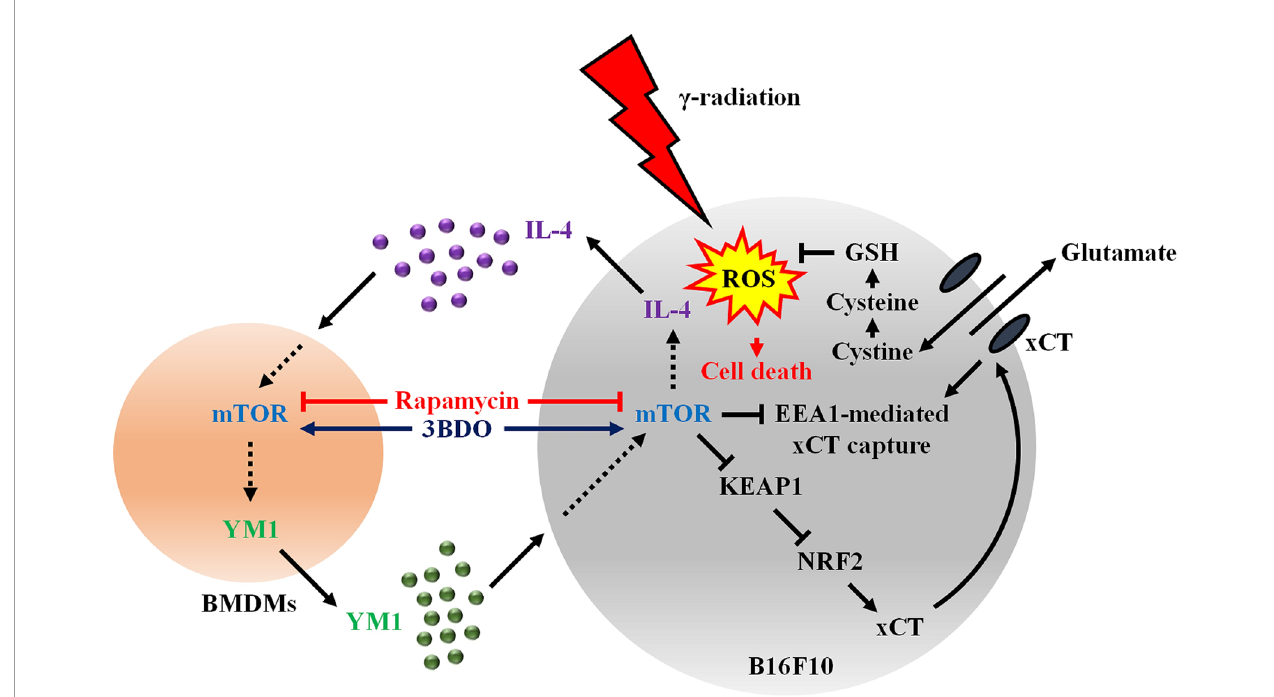
FIGURE 8 | Activated mTOR signaling induces the secretion of IL-4 in melanomas and YM1 in macrophages in the tumor microenvironment. Secreted YM- 1enhances the EEA1-mediated xCT capture via the KEAP1/NRF2 signaling pathway to promote antioxidant mechanisms through GSH in radiotherapy. Therefore, the regulation of mTOR activity using rapamycin could increase tumor sensitivity to g -radiation-induced ROS by inhibiting the interaction between melanoma and